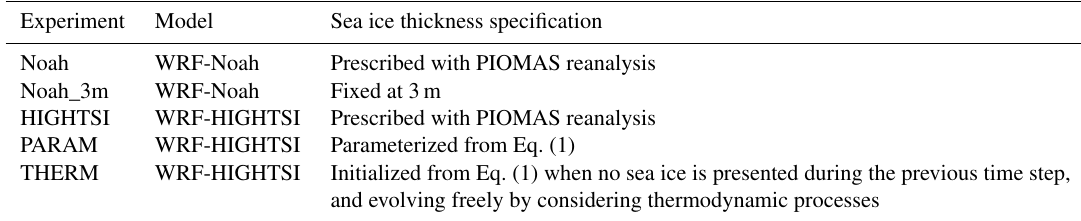
Table 2. Experiment setup for studying the impact of the sea ice thickness